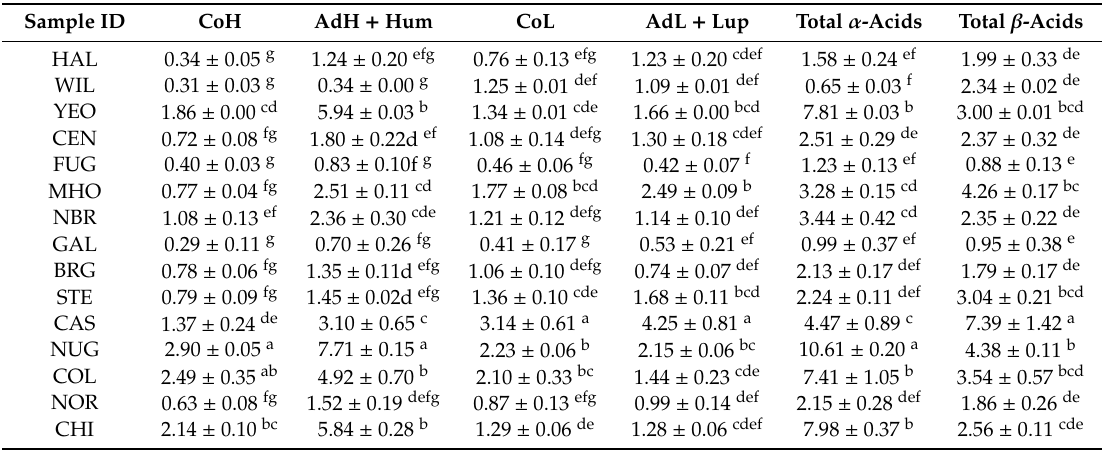
Table 2. Content of α - and β -acids (g / 100 g dry matter, mean ± SD) of hop cones harvested from 15 varieties cultivated in the Marche region (Central